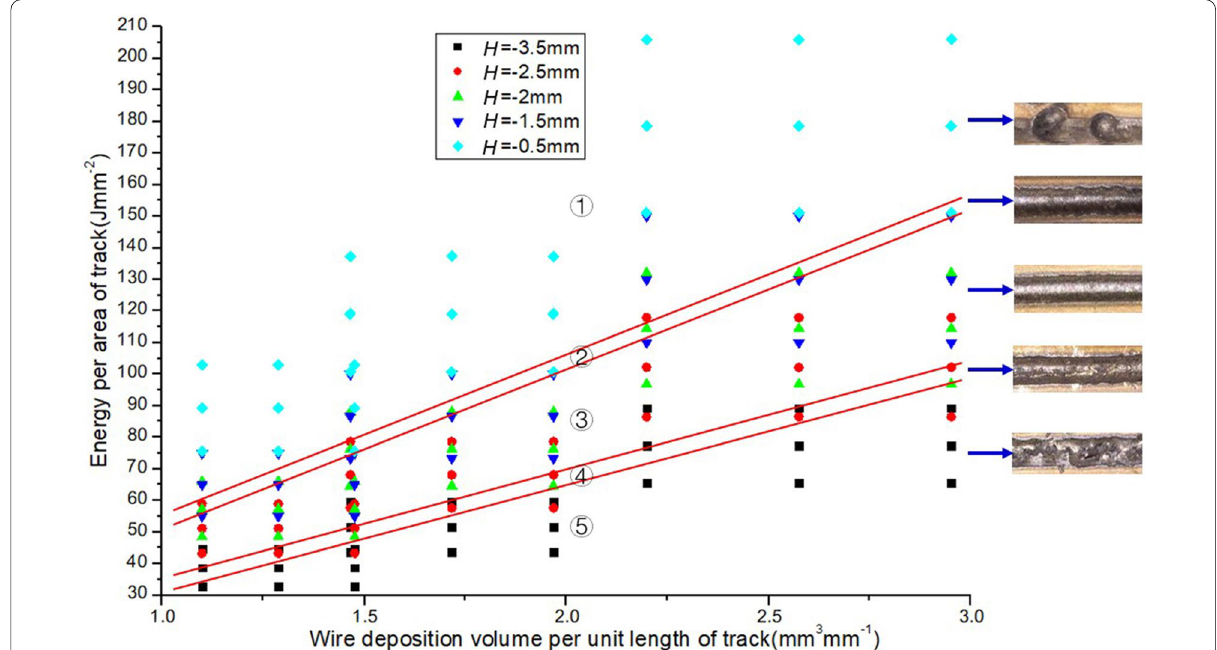
Figure 13 Process map for three-beam laser with internal wire deposition characteristics at different defocus distances with various parameter smooth surface, possible stubbing, and stubbing are defined, respectively. Typical examples of the clad surface characteristics in the five regions are also presented in Figure 13. The energy per unit area ( E L ) on the y -axis of the map is expressed as where P is the laser power, V S is the scanning speed. 2 ( R 1 + R 2 ) is the outer diameter of the circle formed by the three beams, and positively dependent on the defocus distance (Figure 12).